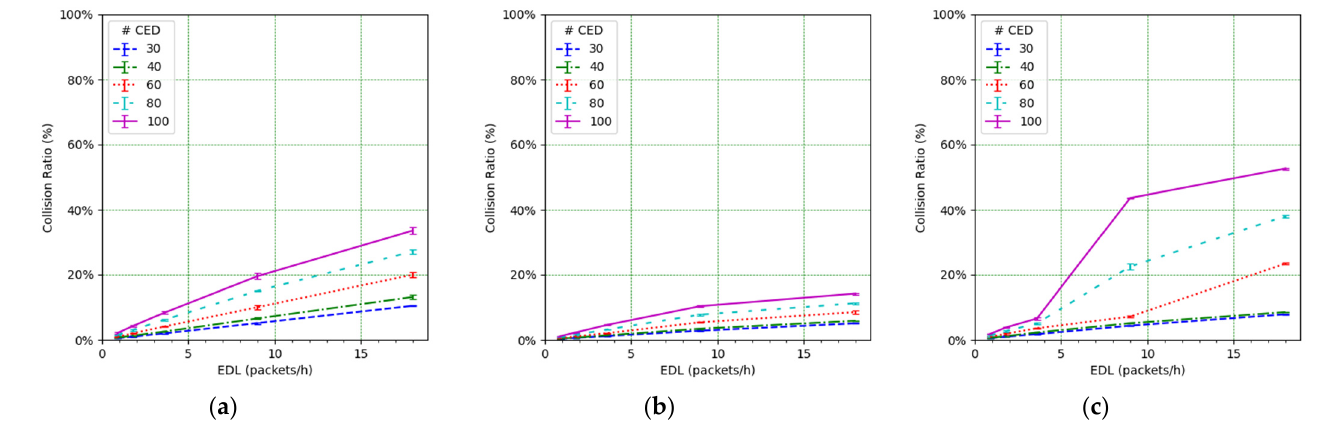
Sensors 2021 , 21 , x FOR PEER REVIEW